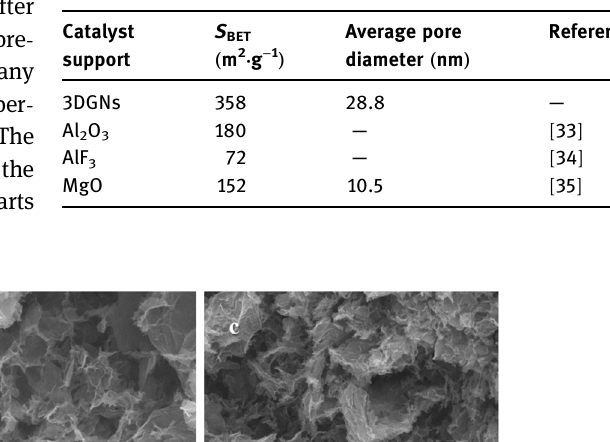
Table 1: Comparison of speci fi c surface areas of di ff erent